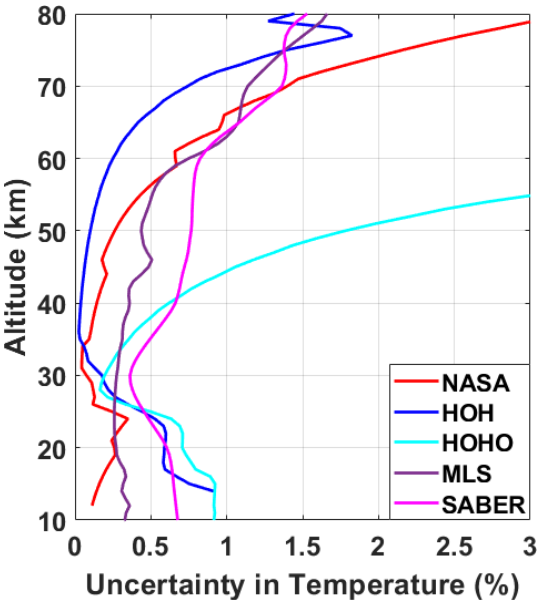
Figure 14. Relative uncertainties in ozone for all HOPS instru-